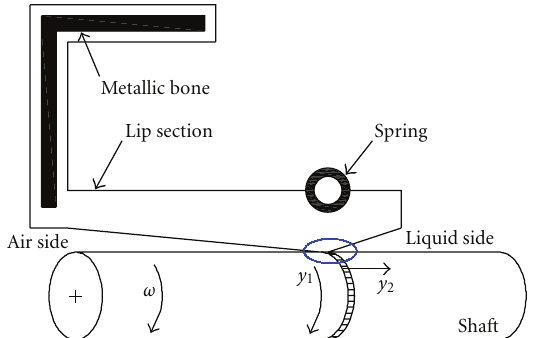
Figure 3: A schematic of a typical lip seal construction. A garter spring enables the radial compression of the seal lip on the shaft surface, ideally preventing fluid leakage from the high pressure side (the fluid reservoir) to the low pressure side. In the running-in stage, the seal lip is macroscopically reshaped as a consequence of the initial lip wear process, which depends on the seal-shaft designed interference and on the solids chemical and physical a ffi nity with the actual lubricant composition. After this bulk material removal (and depending on the viscoelastic rubber properties), a successful seal reaches a steady-state configuration with a well defined roughness pattern, strongly dependent on the actual shaft micro-geometry, and with an established thin lubricant film at the